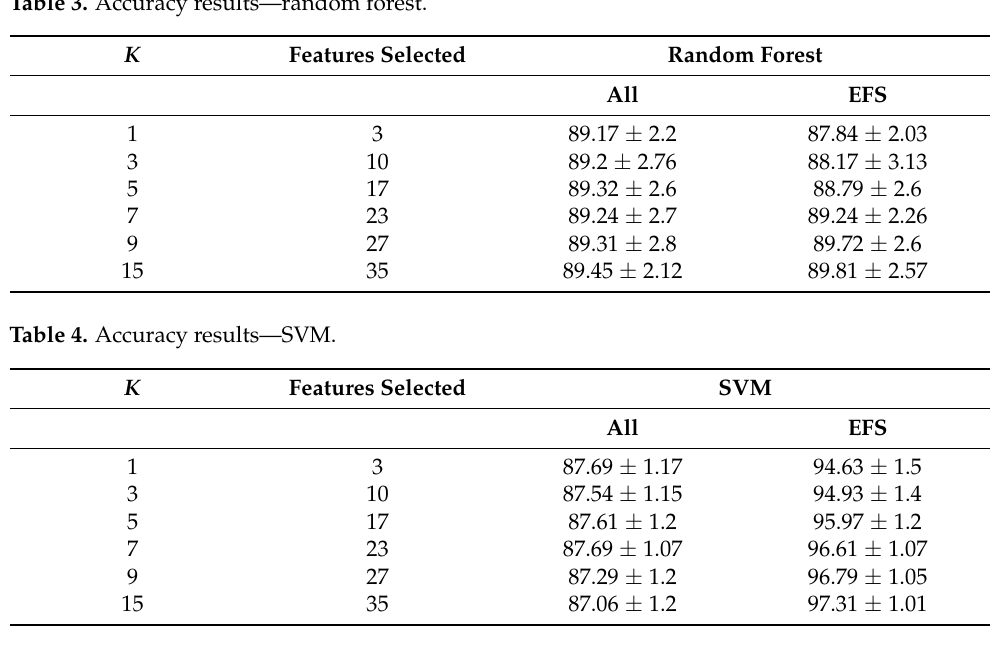
Table 3. Accuracy results—random forest.